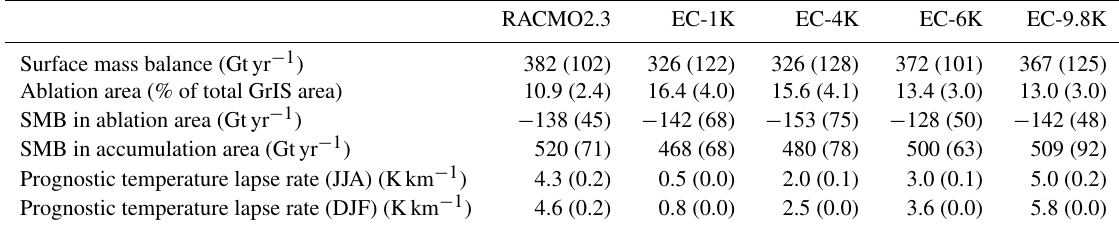
Table 2. Simulated whole-ice-sheet SMB, ablation area, total SMB in the ablation and accumulation areas, and prognostic near-surface tem- perature gradients for the four simulations performed in this study with varying lapse rates and for the reference regional model RACMO2.3. Values correspond to the climatological (1965–2005) average with the standard deviation in